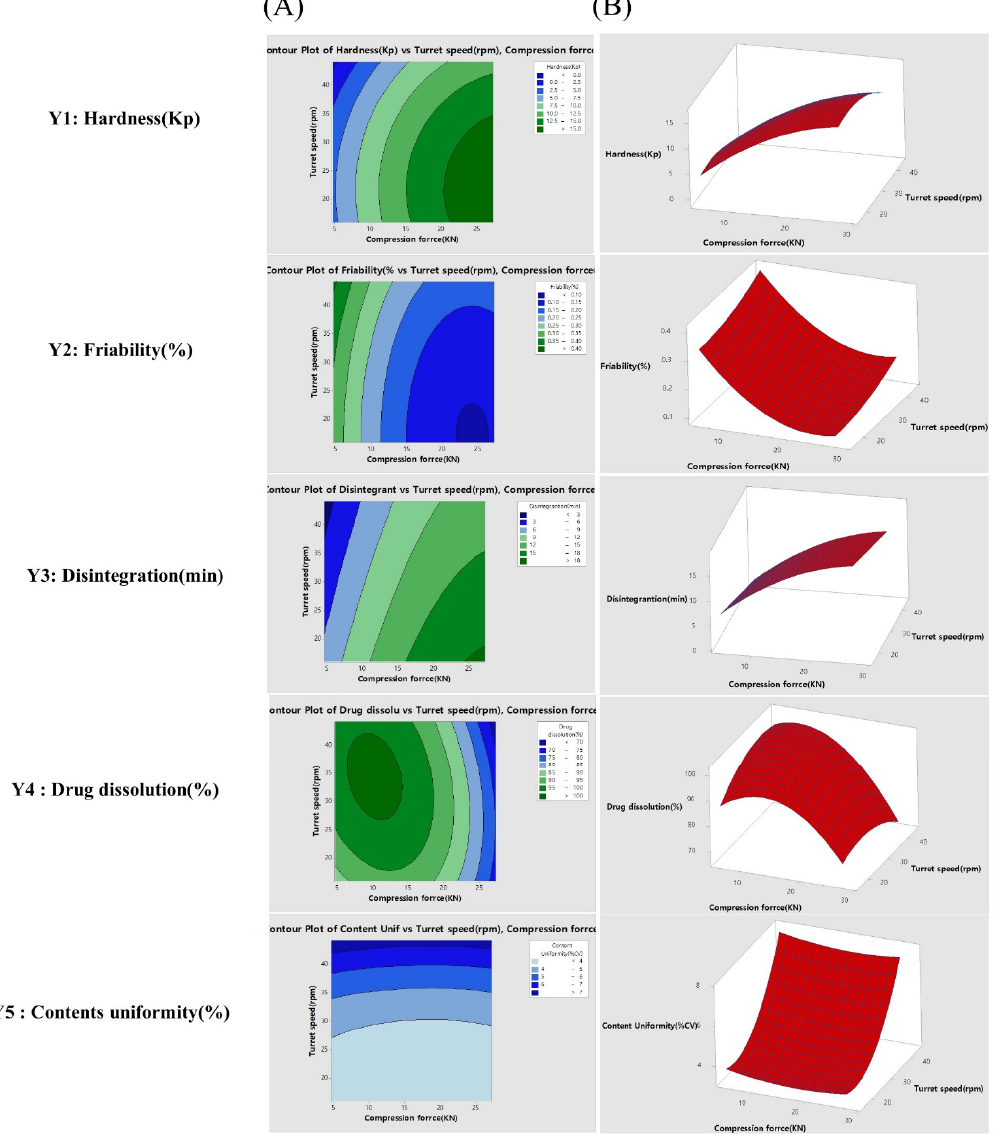
fected the dissolution values.